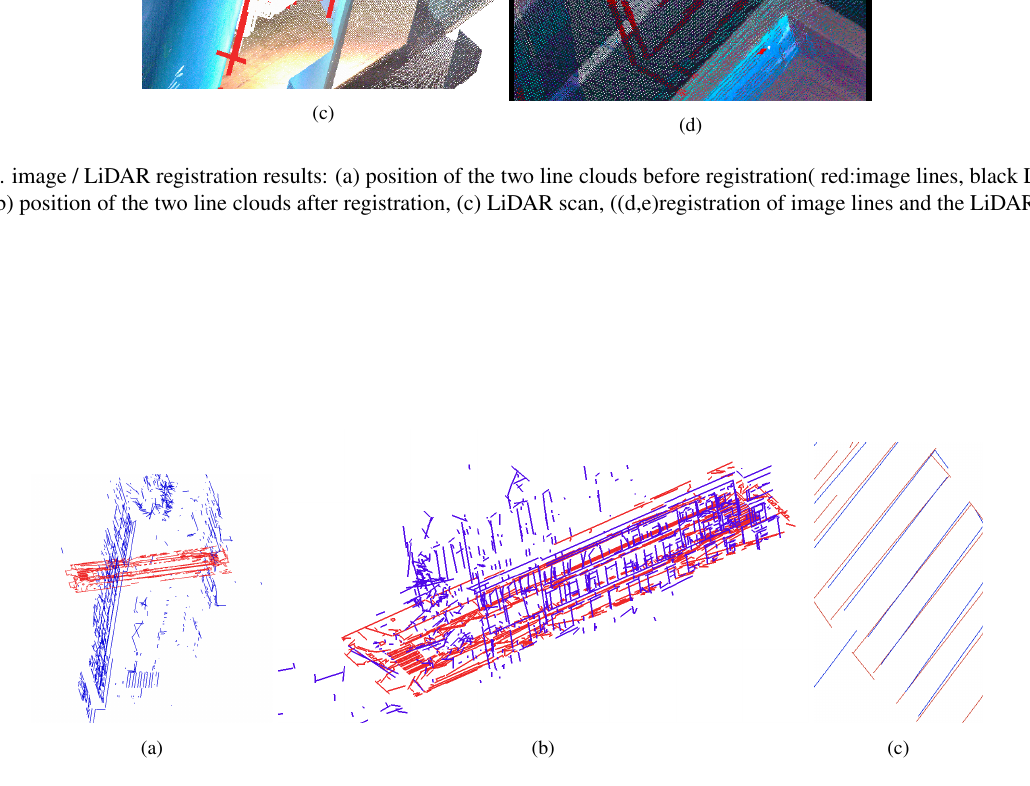
Figure 6. Aerial/Terrestrial registration: 3D lines reconstructed aerial image(red), 3D lines reconstructed from terrestrial images (blue) (a): the initial position, (b): positions after registration, (c): position of pedestrian path lines after